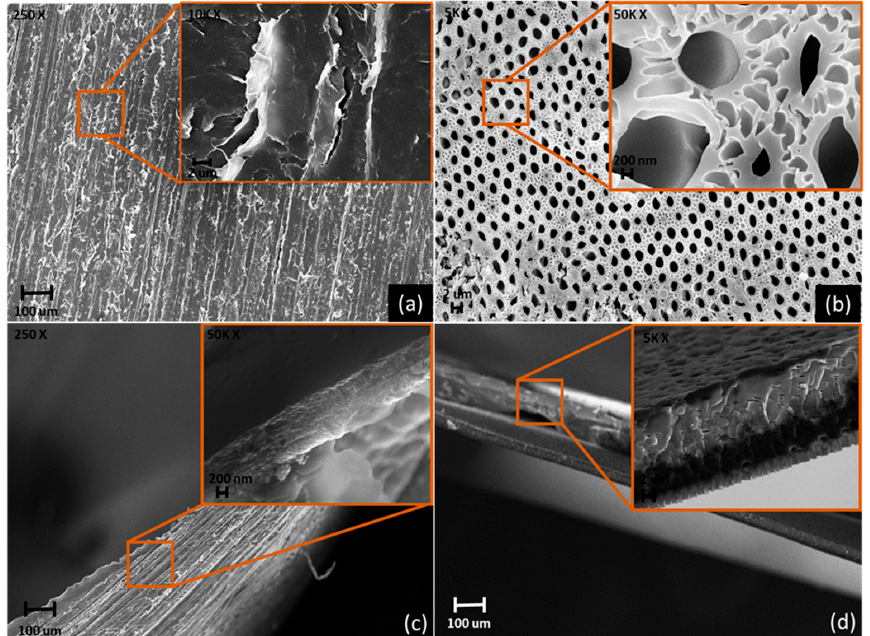
Figure 4. FESEM capture of surface ( a ) PIM-1, ( b ) PIM-1/[BMIM][Ac] 10/1 and their cross sections ( c ) and ( d ), respectively.